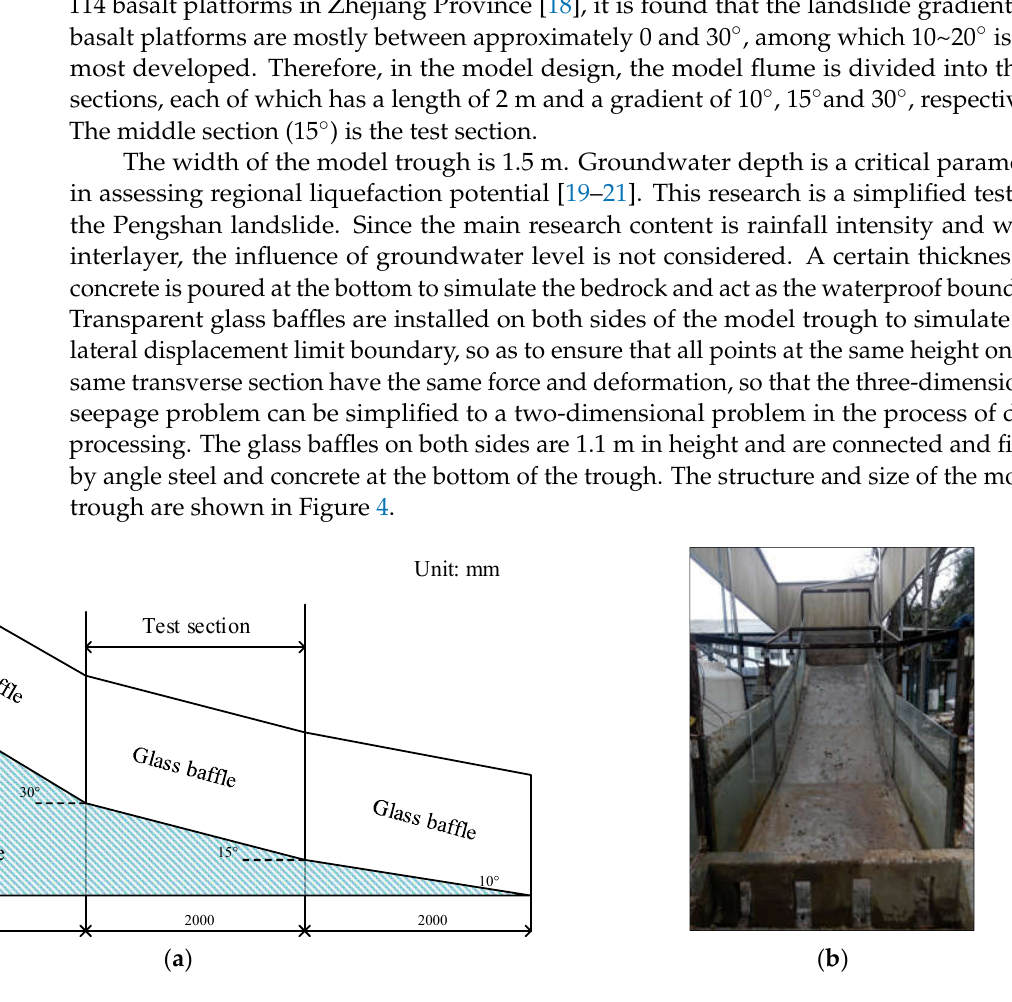
Figure 4. Sketch of the physical model test flume. ( a ) Model box size. ( b ) Model test flume.